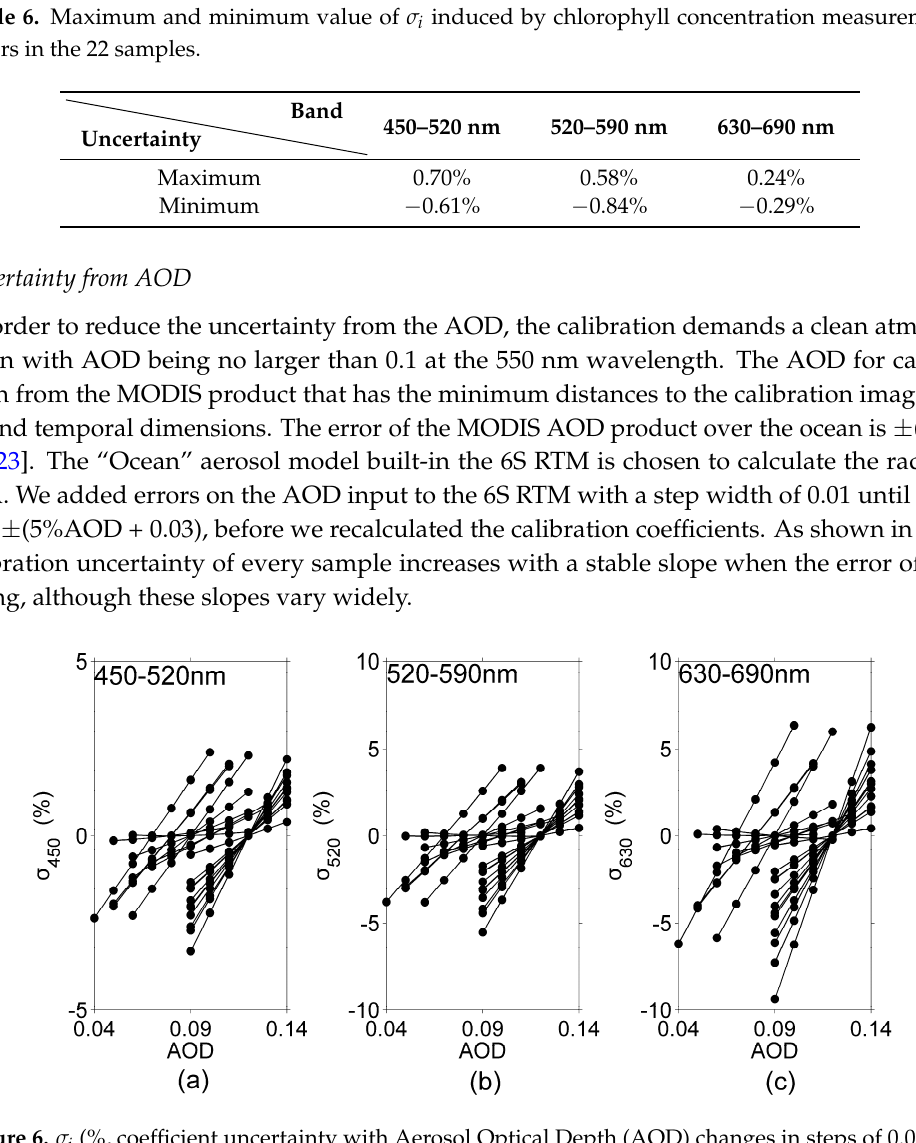
Figure 7. (cid:2026) (cid:3036) (%, coefficient uncertainty with Aerosol Optical Depth (AOD) changes ± (5%AOD + 0.03)) of 22 examples versus: ( a ) AOD and ( b ) solar zenith angle (marked color represents different bands: 450–520 nm (blue), 520–570 nm (green), and 630–690 nm (red)).